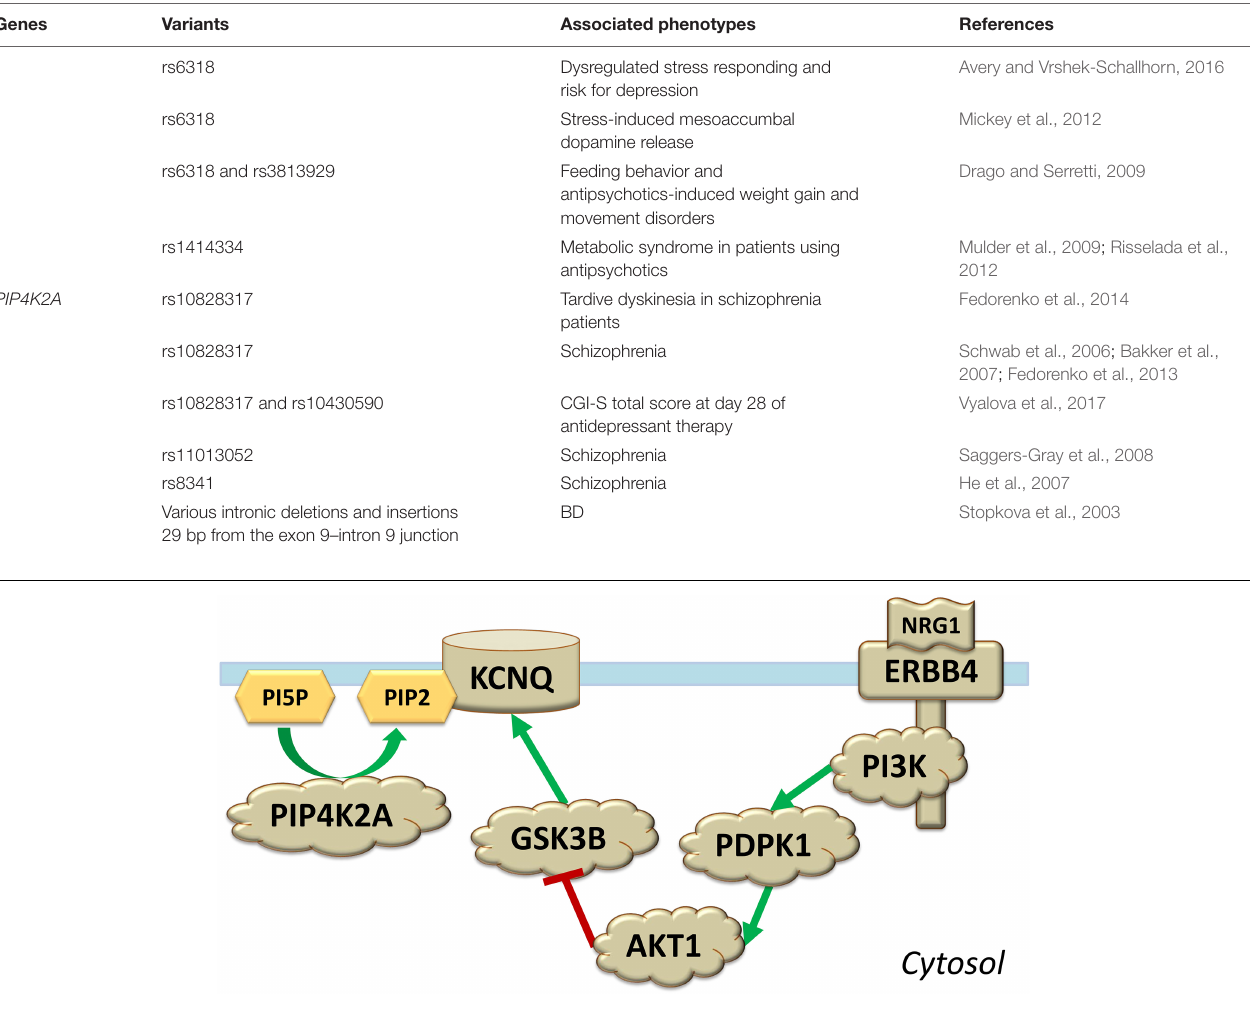
FIGURE 1 | Shown are molecular interactions involving protein products of PIP4K2A and NRG1 associated with time to recurrence of an episode in bipolar disorder and antidepressant treatment response. Phospholipids phosphatidylinositol-5-phosphate (PI5P) and phosphatidylinositol-5,4-bisphosphate (PIP2) are located on the intracellular leaflet of the plasma membrane, while the channel KCNQ and the receptor ERBB4 are transmembrane. The binding of NRG1 to the receptor tyrosine kinase ERBB4 results in subsequent activation of phosphoinositide 3-kinase (PI3K), 3-phosphoinositide-dependent protein kinase-1 (PDPK1), and AKT1; the latter kinase inhibits